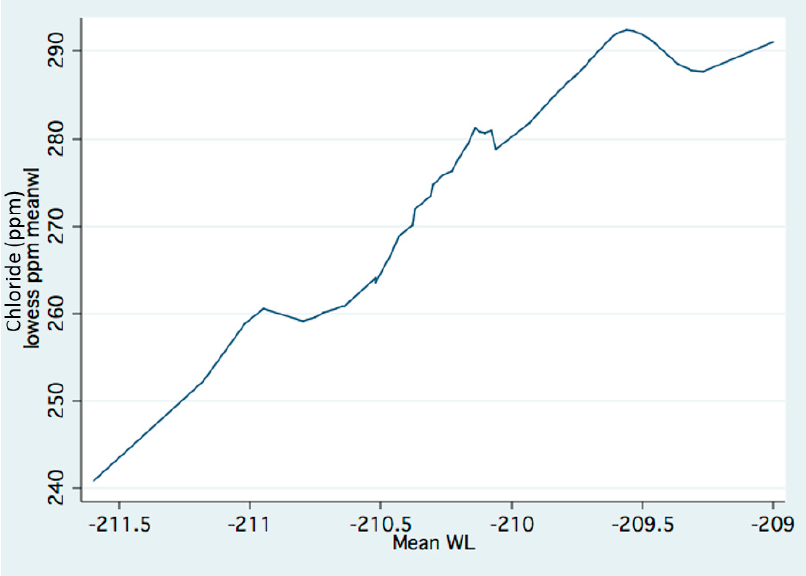
Figure 19. Trend of changes (LOWESS 0.8 bandwidth) of mean annual concentration of chloride (ppm) in relation to annual mean of WL in Lake Kinneret during 1933–1969.